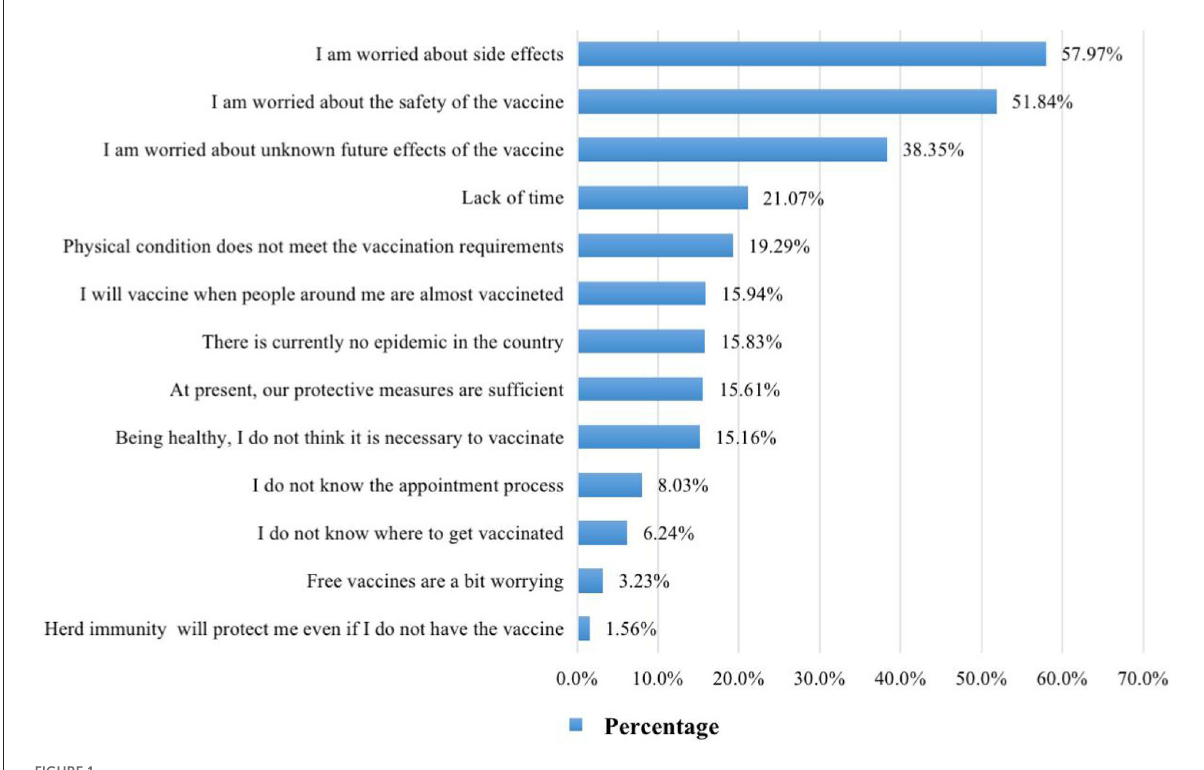
FIGURE1 Hesitancy